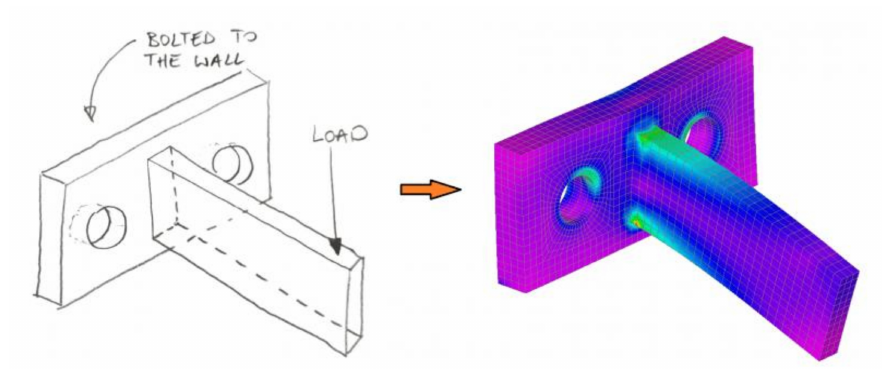
Figure 7. Mesh deformation after